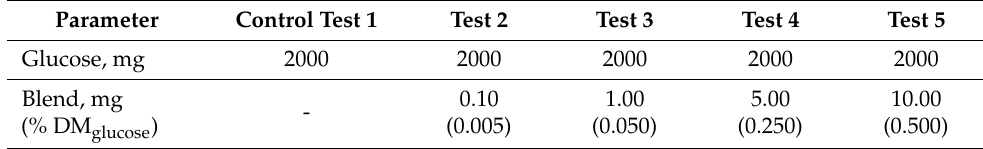
Table 1. Experimental protocol for assay 1 (powder form blend with 10%